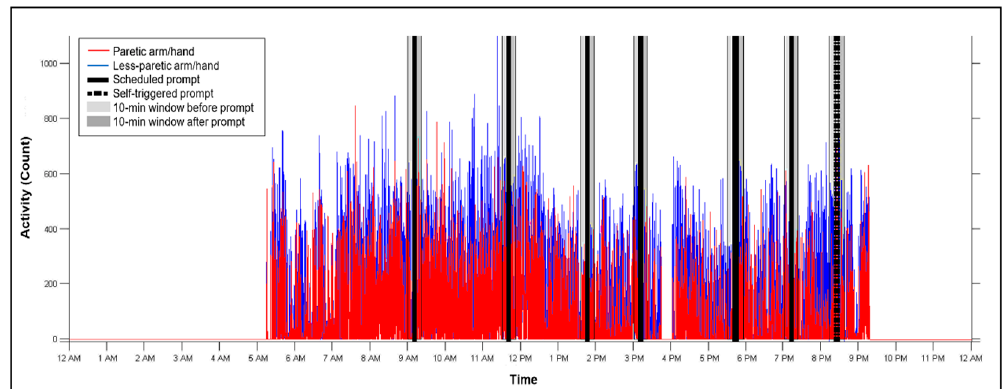
Figure A1. Synchronization of accelerometer data with EMA prompt times. An example from one participant for 24-h accelerometry data.